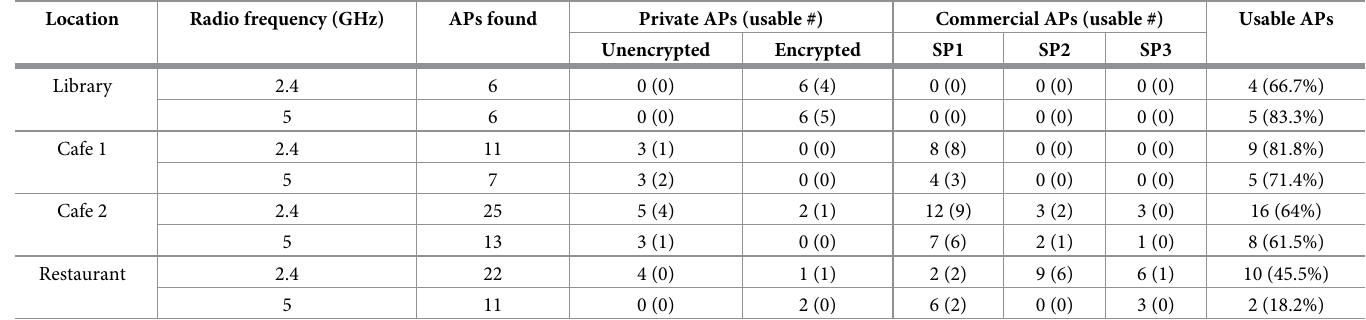
Table 1. AP statistics in our field study.